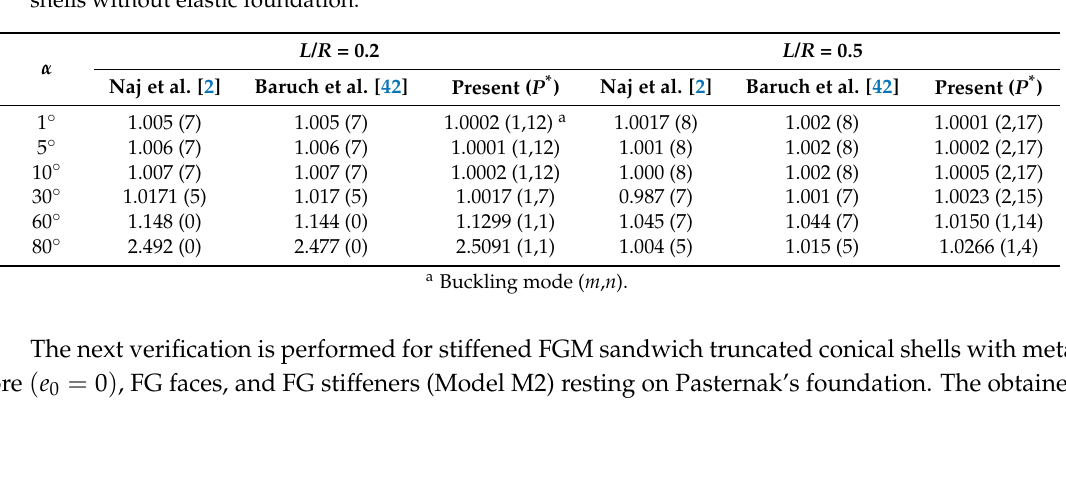
Table 2. Dimensionless buckling axial compressive loads of un-stiffened isotropic truncated conical shells without elastic